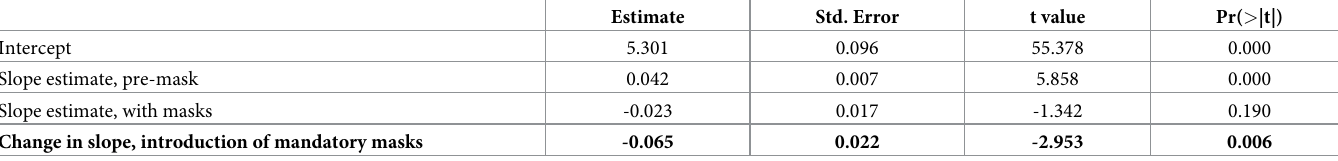
Table 2. Coefficients from the linear spline model with a knot on 31st